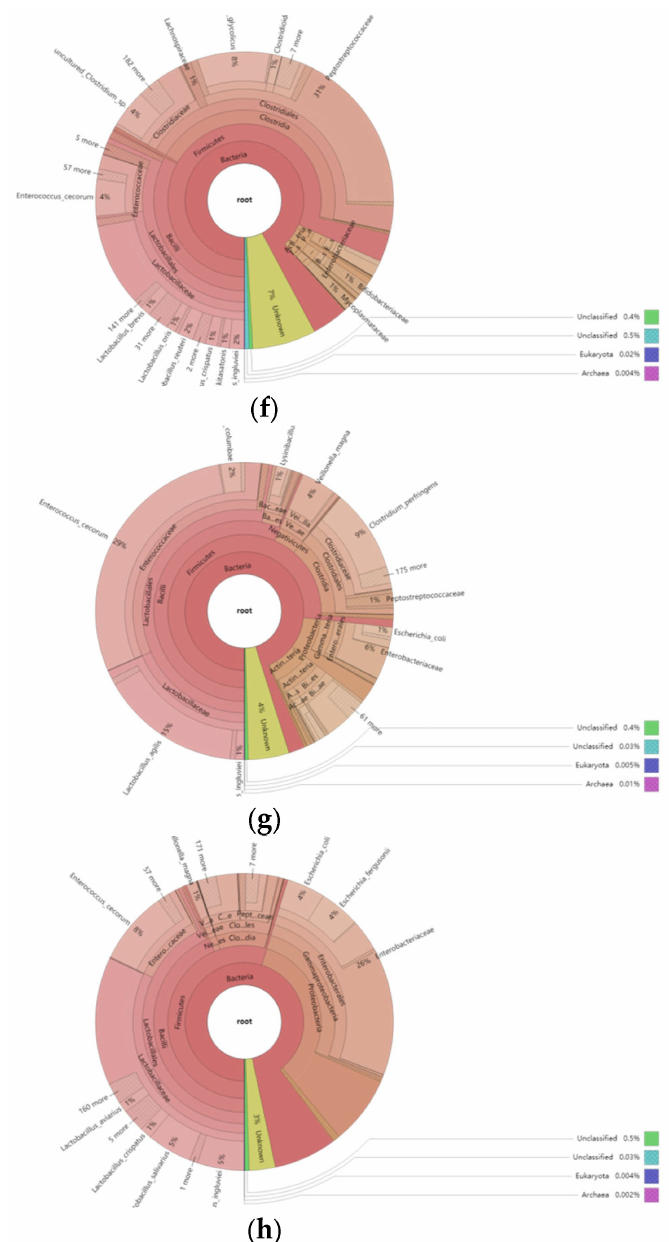
Figure 6. ( a – h ). Annotate results for species using Krona. In Figure 6, the circles represent different taxonomic levels (kingdom, phylum, class, order, family, genus, species) from inside to outside; the size of the sector represents the relative proportion of different